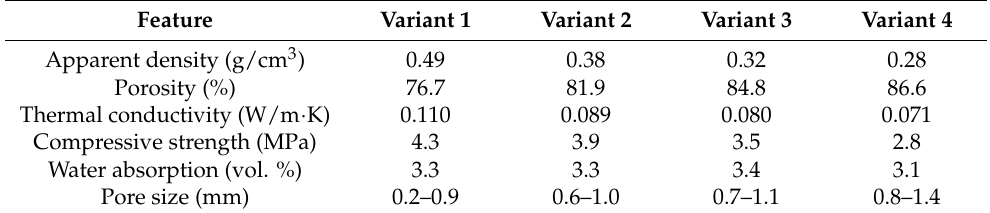
Table 4. Main physical, thermal, mechanical and microstructural features of glass foam samples.